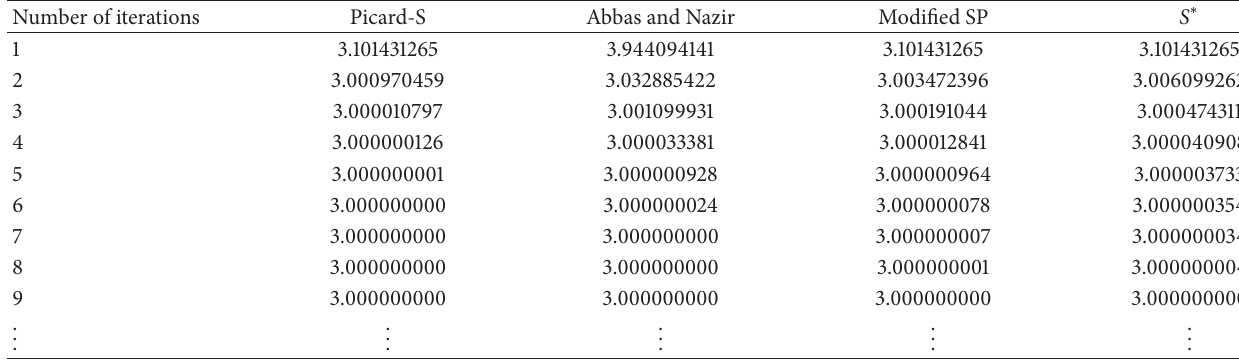
Table 1: Comparison speed of convergence among various iteration methods.